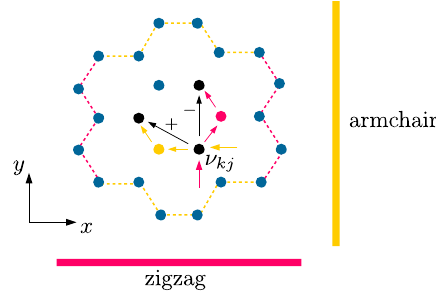
Figure 5. Schematic view of the ν kj (Eq. 4) sign for two different edge types of silicene. For the same considered atom j paths to the next-nearest neighbor k differ in zigzag and armchair configuration and produce opposite sign of the local effective magnetic field resulting from KM term. This will produce mirrored image of spin signs in subband structures for armchair and zigzag.